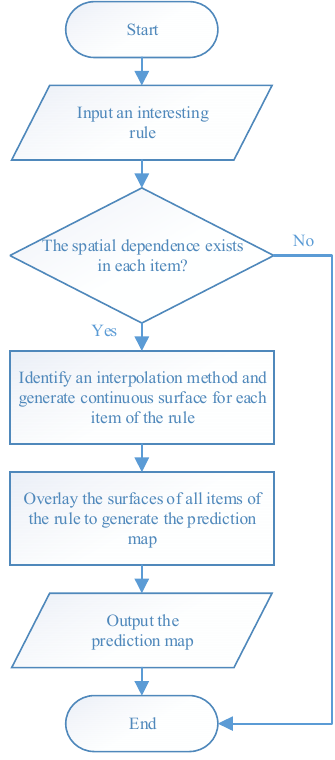
Figure 1. The flow chart of Surface-based geovisualization.